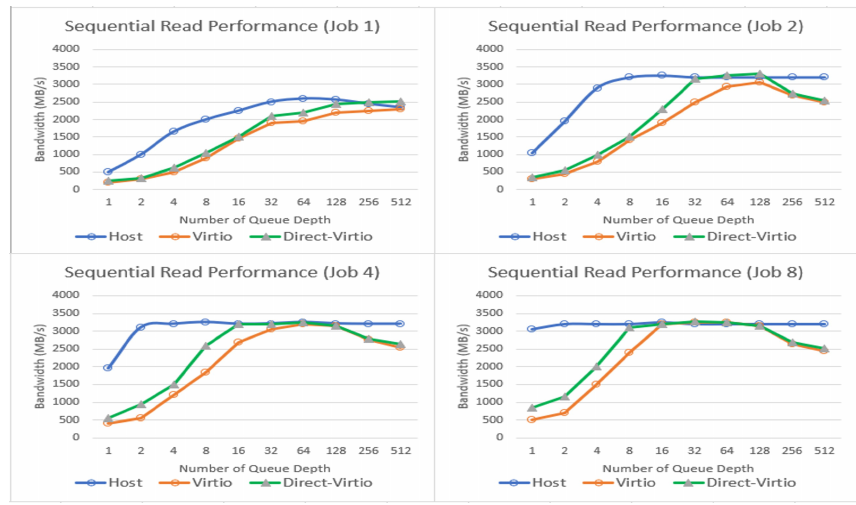
Figure 9. I/O performance comparison between Virtio and Direct-Virtio for sequential read pattern.